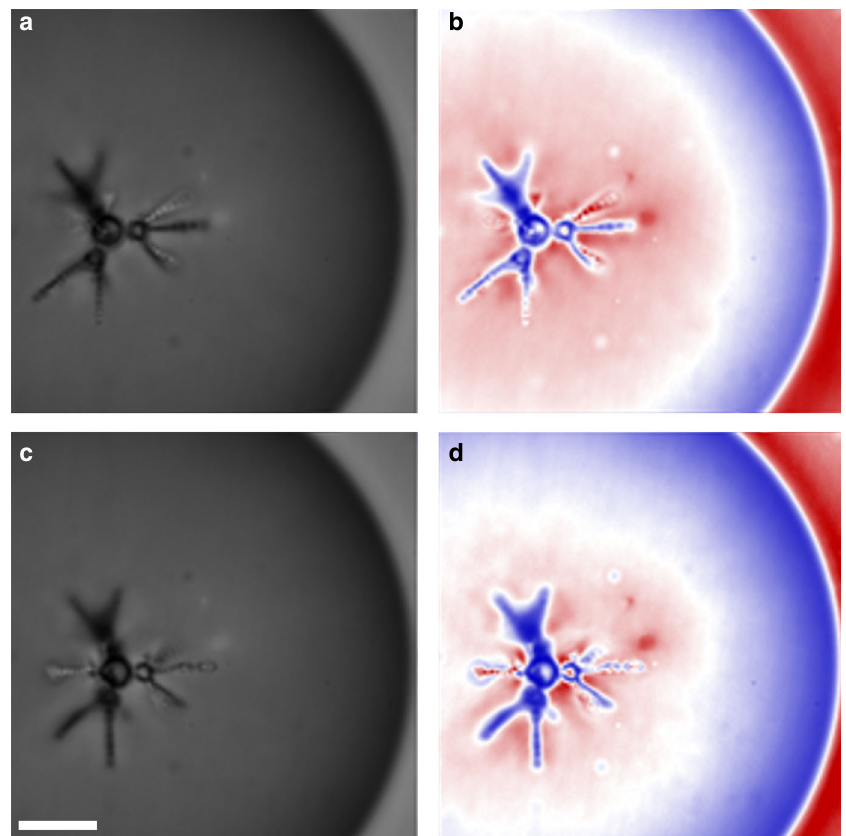
Fig. 7 Fractal satellite packing. Confocal microscopy images showing a self-assembled fractal structure with 2 steps of evolution, formed by water inclusions with normal boundary condition inside a radial nematic droplet. Images a , c show different orientations of the same structure. Images b , d show the corresponding visually enhanced equivalents. Scale bar: 10 μ